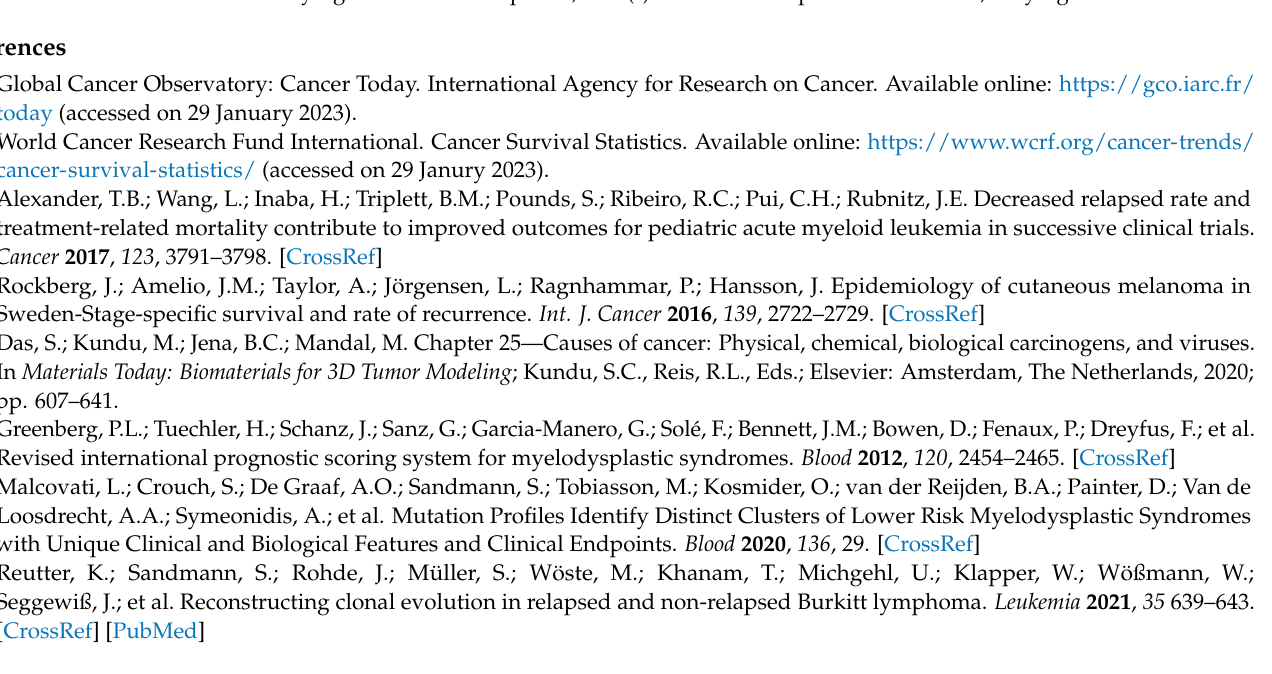
Figure A15. Number of trees reported using ClonEvol, ClonalTREE, SCHISM, and TrAP, while ClonalTREE and SCHISM always report a single tree, ClonEvol and especially TrAP usually report more than one possible tree; ( a ) linear evolution, varying number of time points, ( b ) linear evolution, varying number of clones, ( c ) branched dependent evolution, varying number of time points, ( d ) branched dependent evolution, varying number of clones, ( e ) branched independent evolution, varying number of time points, and ( f ) branched independent evolution, varying number of